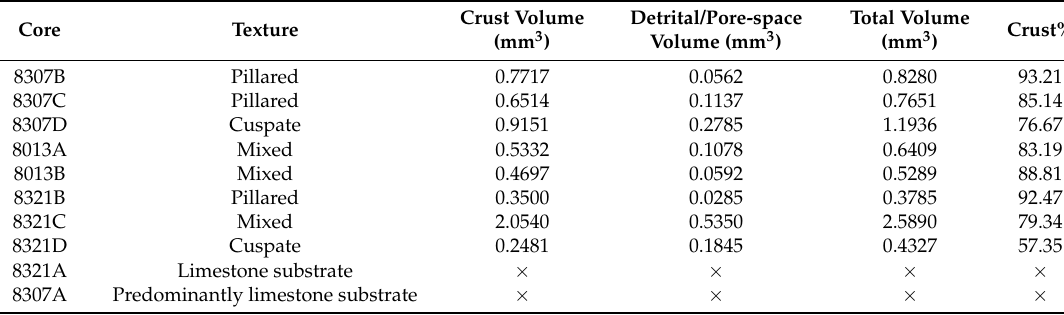
Table 1. Crust volume as a percentage of the total for all the samples measured except 83-21 A and 83-07 A, which were through the substrate. The pillared samples contain much more FeMn crust as a percentage of their volume than did the cuspate